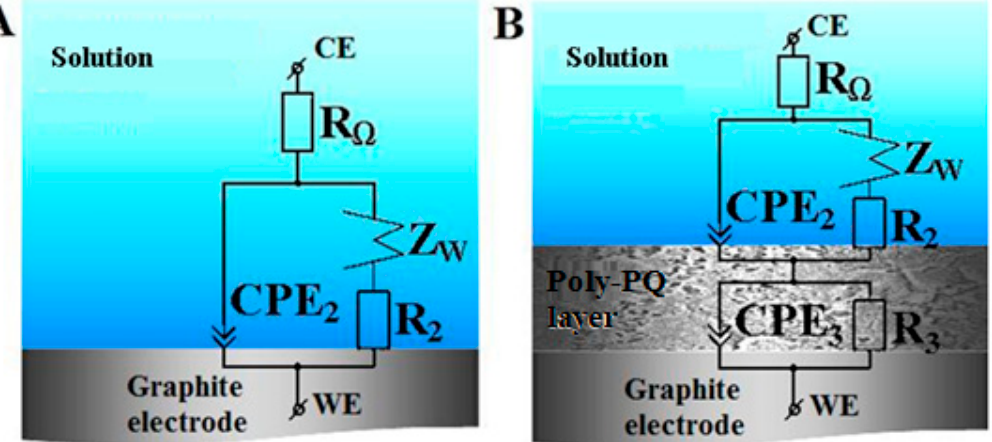
Figure 3. Equivalent circuit for ( A ) clean and ( B ) poly-PQ coated graphite electrode. Table 1. Graphite rod electrode under various polymerization steps in polymerization medium.